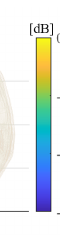
Figure 14. Amplitude values of the reconstructed dielectric contrast for a false-positive scenario in the HP case; transverse view cut in its maximum, normalized to the maximum value of ICH-HP_I. The red circle indicates the position of the average brain filled